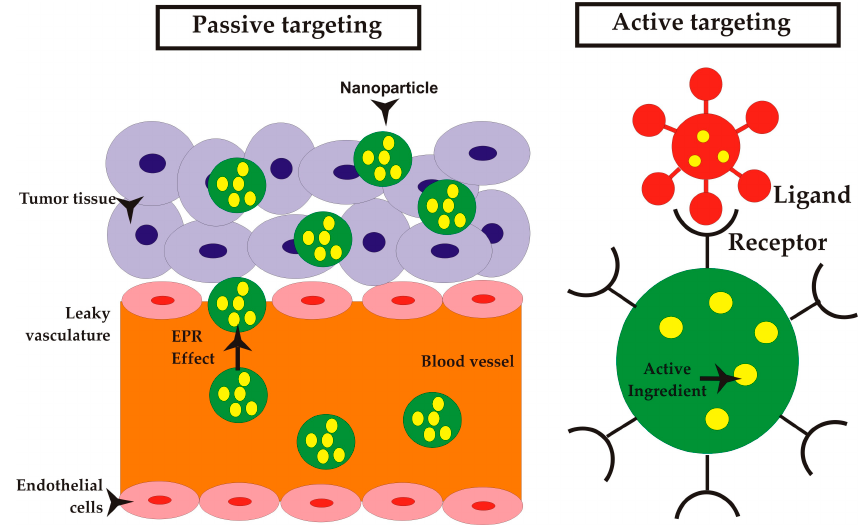
Figure 5. Mechanisms in drug delivery.